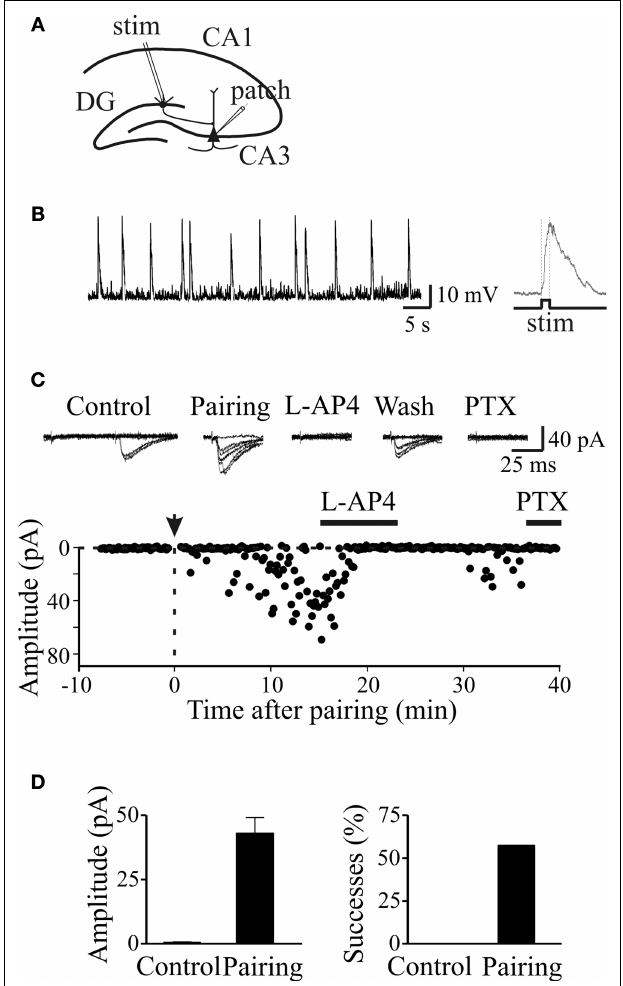
FIGURE 5 | Pairing switched on apparent “presynaptically” silent neurons. (A) Diagram of the hippocampus showing a CA3 pyramidal cell receiving a MF input. The stimulating electrode (stim) is in granule cell layer. (B) GDPs recorded from a CA3 pyramidal cell in current-clamp mode from the hippocampus at P2. On the right, a single GDP is shown on an expanded time scale (the intracellular solution contained QX 314 to block action potentials). The rising phase of GDPs (between the dotted lines) was used to trigger synaptic stimulation. (C) Peak amplitudes of MF-GPSCs before and after pairing (arrow at time 0) are plotted against time. The traces above the graph represent individual responses evoked in different experimental conditions. This synapse was considered “presynaptically” silent since it did not exhibit any response to the fi rst stimulus over 48 trials (at 0.1 Hz) but occasional (two) responses to the second one. (D) Mean GPSCs amplitude and mean percentage of successes before (Control) and after pairing ( n = 5). Modifi ed from Kasyanov et al.